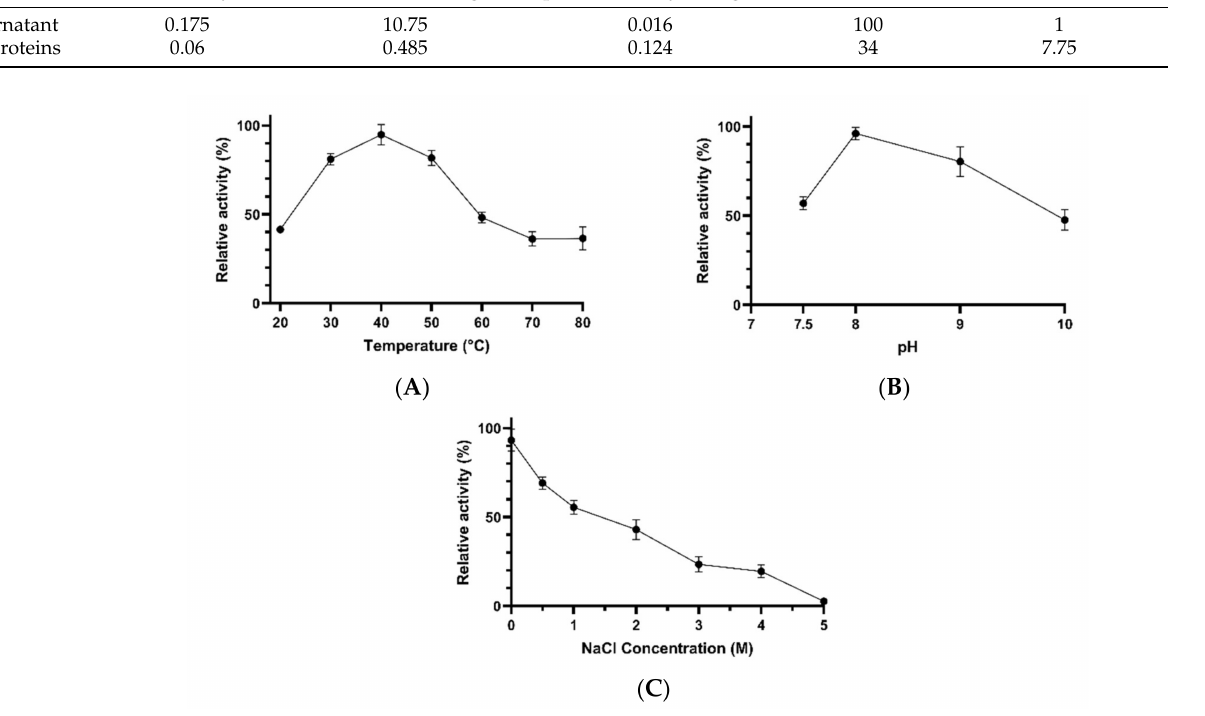
Figure 5. The effects of temperature ( A ), pH ( B ) and NaCl concentration ( C ) on the activity of concentrated esterases obtained from Bacillus sp. BA N P3.3. Error bars represent the standard deviation of the mean ( n =